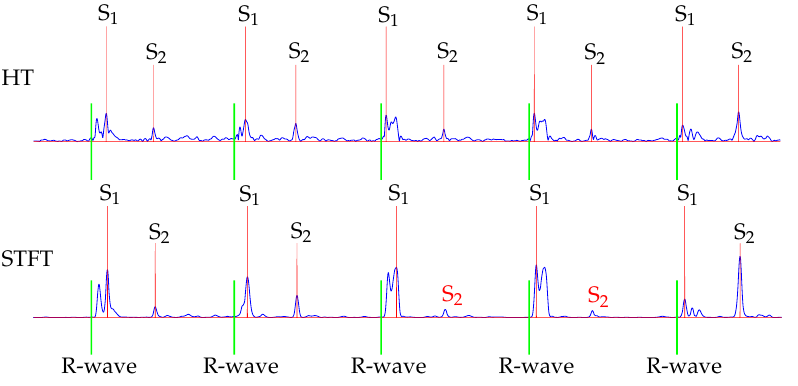
Figure 10. Example of classified heart sounds, where the detection of S 2 failed in some cases for the STFT (red). The reference ECG is shown in green.